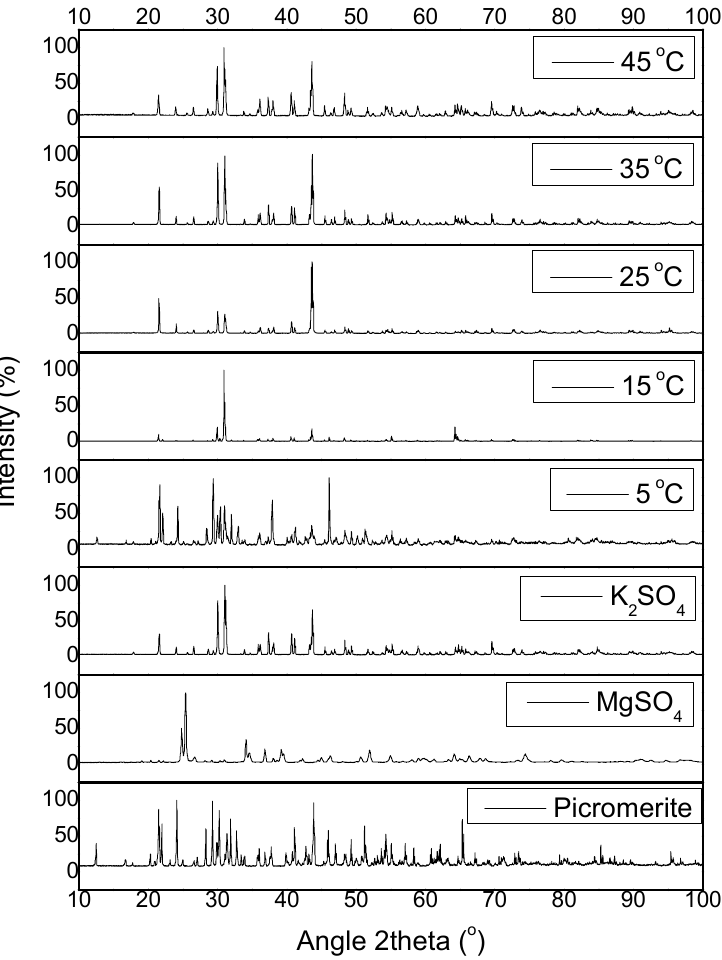
Figure 11. X-ray powder patterns of K 2 SO 4 , MgSO 4 , picromerite and K 2 SO 4 product obtained at reactive crystallization temperatures of 5, 15, 25, 35 and 45 °C (from bottom to top).